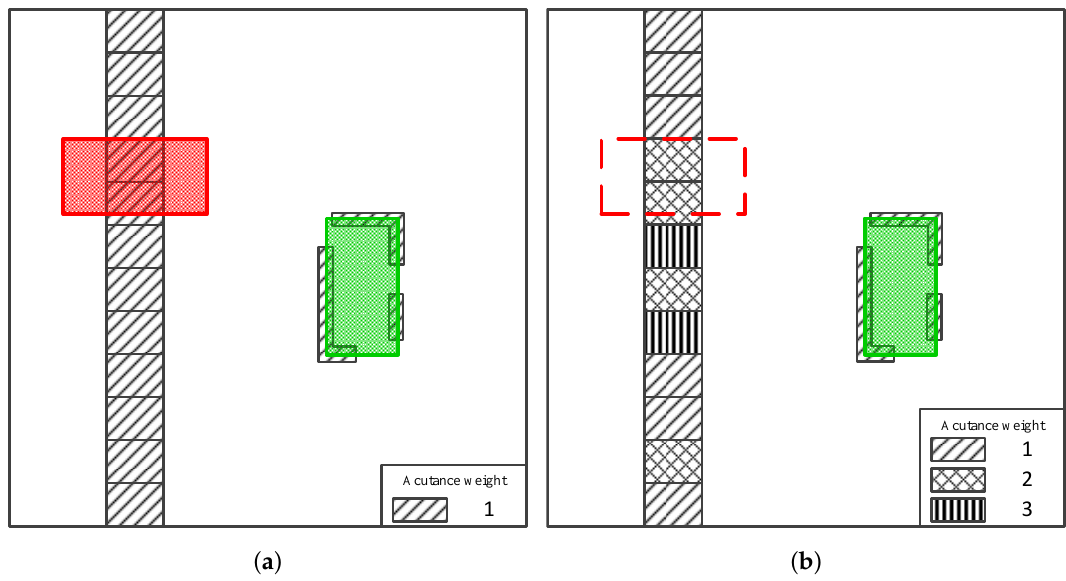
Figure 5. Schematic diagram of the false alarm reduction via gradient-weighted edge information. ( a ) Description of unweighted edge detection case. ( b ) Description of gradient-weighted edge detection case. Green rectangle indicates the shadow area of a real moving target, red one indicates the false alarm and other patterns of rectangles indicate the edge detection results with different